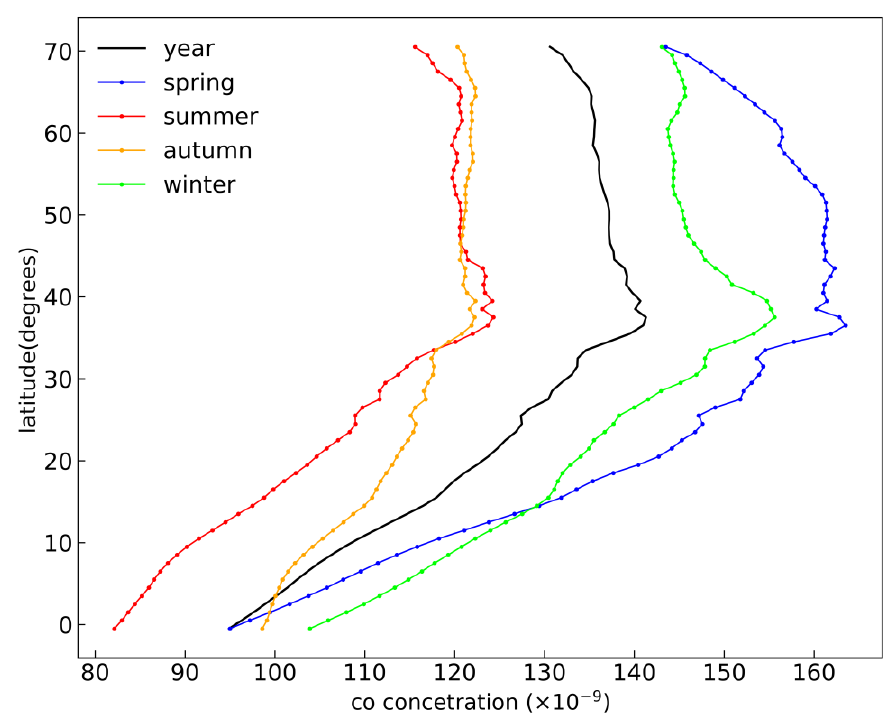
Figure 19. Distribution map of zonal mean concentration of CO in East Asia.